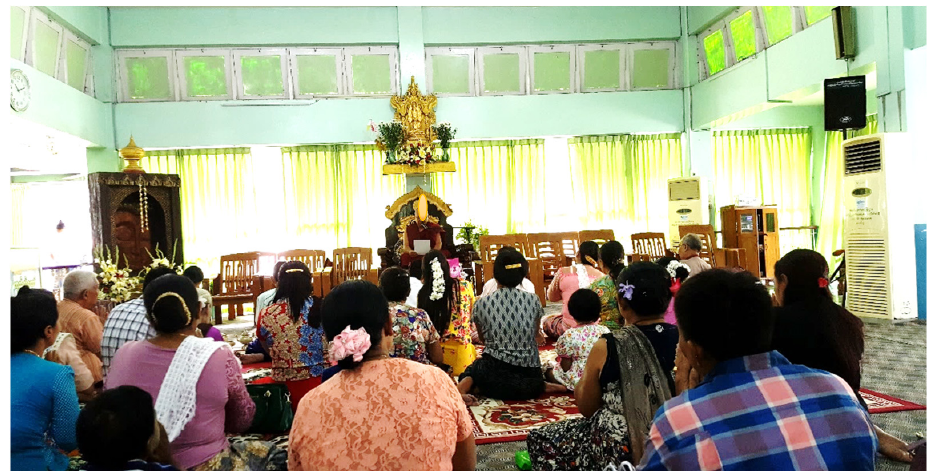
Figure 11. Burmese laity listening attentively as a master lectures (Source: